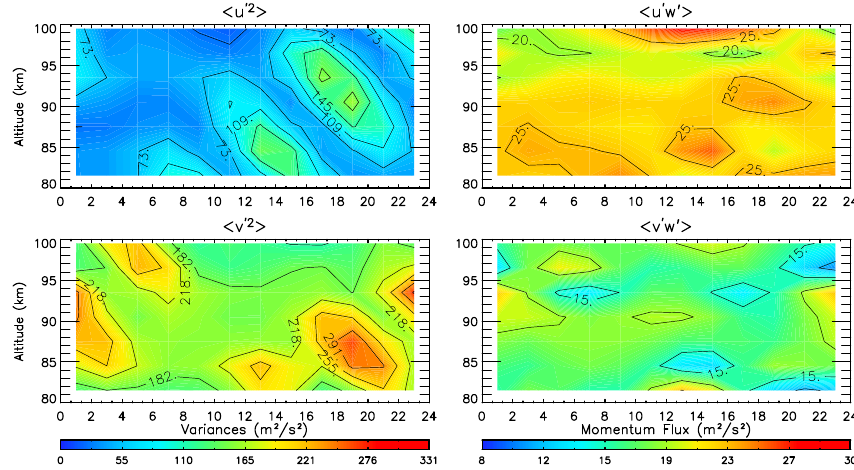
Fig. 7. Variance (left) and momentum flux (right) from Hocking’s analysis. These are for 2h time bins and 3km high intervals.